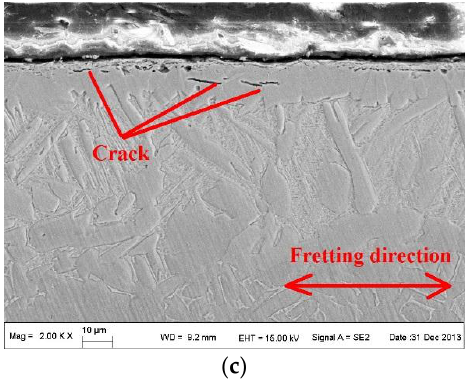
Figure 20. Cross-sectional micromorphology of FF specimen after failure with different modifications.